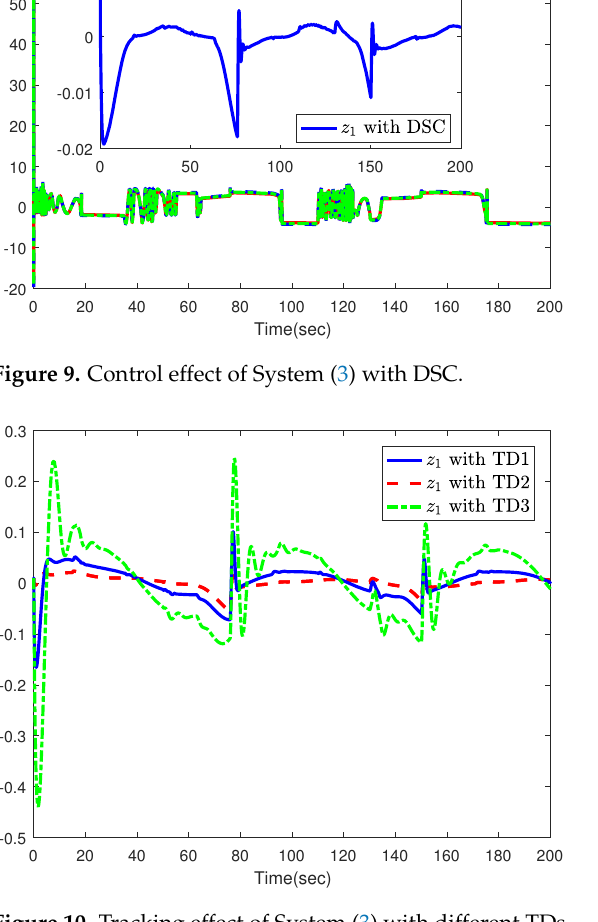
Figure 10. Tracking effect of System (3) with different TDs.